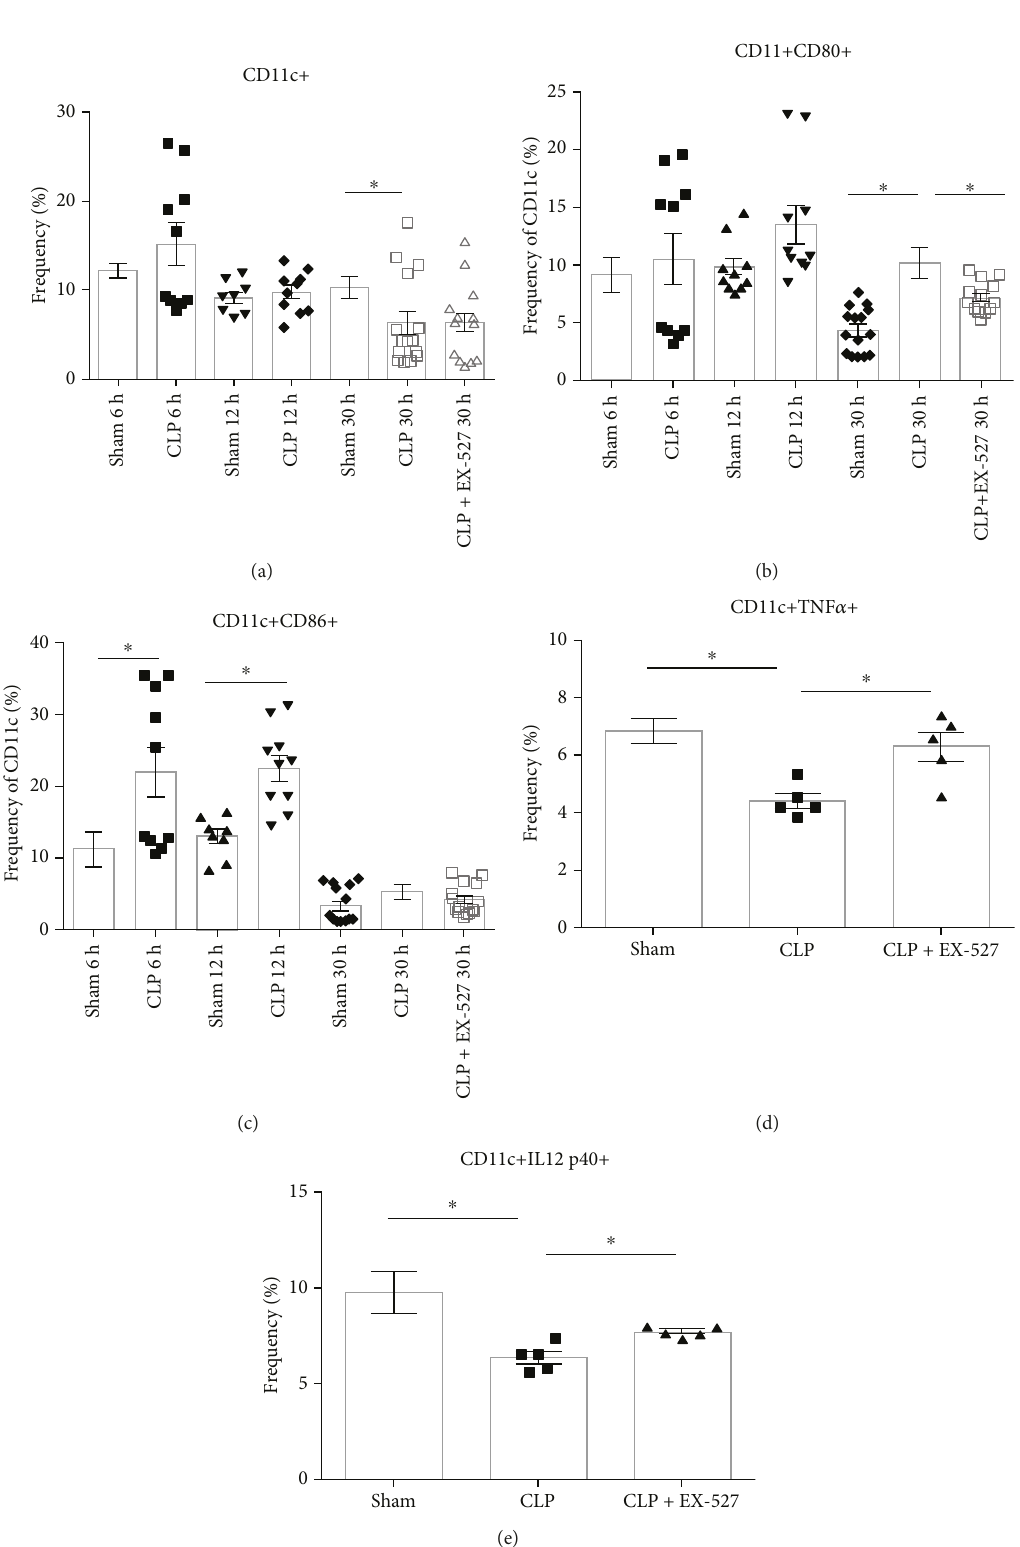
Figure 4: E ff ects of sepsis and SIRT1 inhibition on CD11c+ DC costimulatory markers. (a) Cumulative results of CD11c+ DCs presented as frequency of total splenocytes. (b, c) Cumulative data of CD11c+CD80+ DCs (b) and CD11c+CD86+ DCs (c) presented as frequency of CD11c. (d, e) Cumulative results of CD11c+ DC production of proin fl ammatory TNF α (d) and IL12 p40 (e) cytokines presented as frequency of CD11c. (a – c) Data are representative of two independent analyses with a total of 5 mice in each group. (d, e) Data are a single preliminary analysis with a total of 5 mice in each group. Data are expressed as mean ± SEM. ∗ p < 0 05